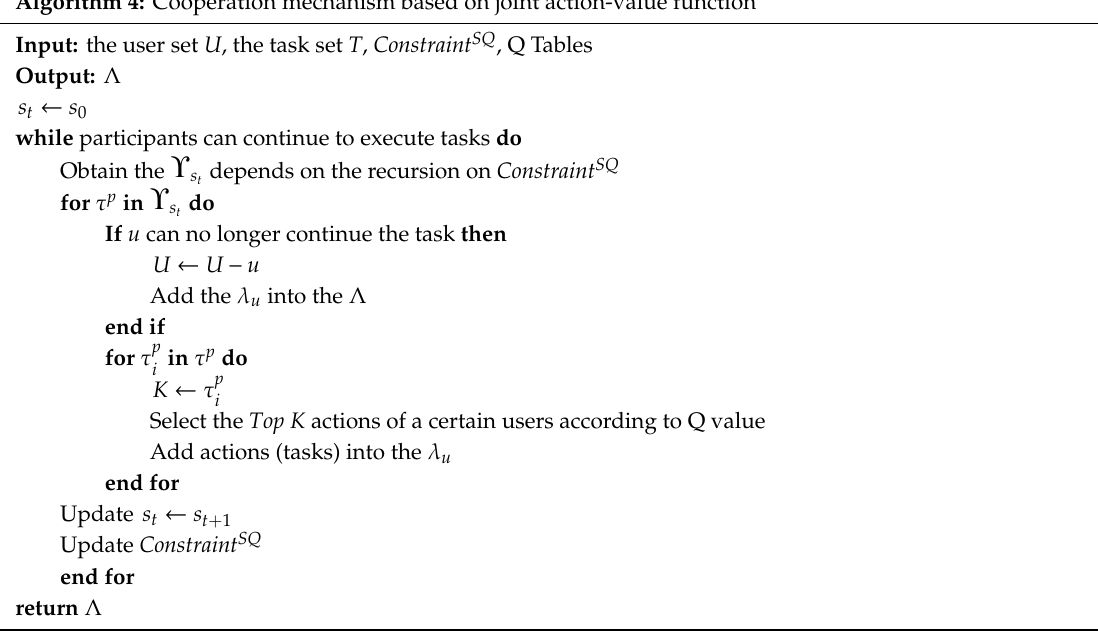
Algorithm 4: Cooperation mechanism based on joint action-value function